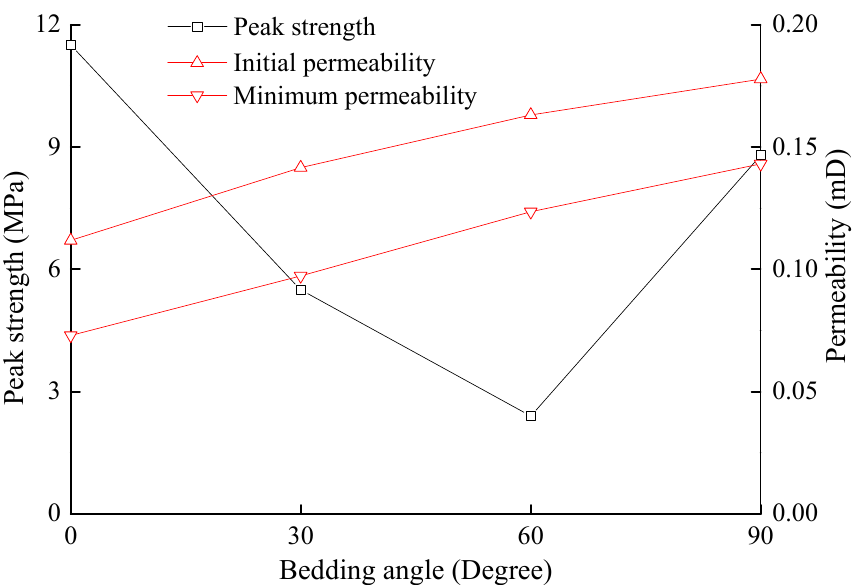
Figure 5. Peak strength and permeability at different bedding angles.